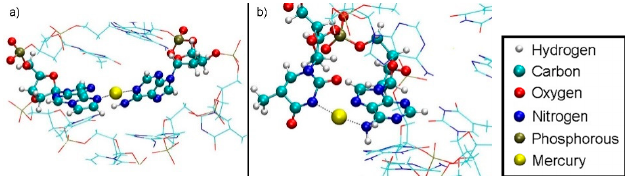
Figure 15. Section of final geometry of structure 1 at D DNA = 5.8 Å with no water displayed. ( a ) Hg2 is bound between A 6-N1 and ε A 20-N6 inside the double helix. ( b ) Hg1 is bound between T 7-N3 and A 8-N6 outside the double helix, with the N6 atom of adenine being hybridized in an sp 3 -like state to engage in a coordinate bond with Hg1. The base pairs bulge of the DNA helix and are dangling in the water, thus forming a contact of the hydrophobic core to the water environment.